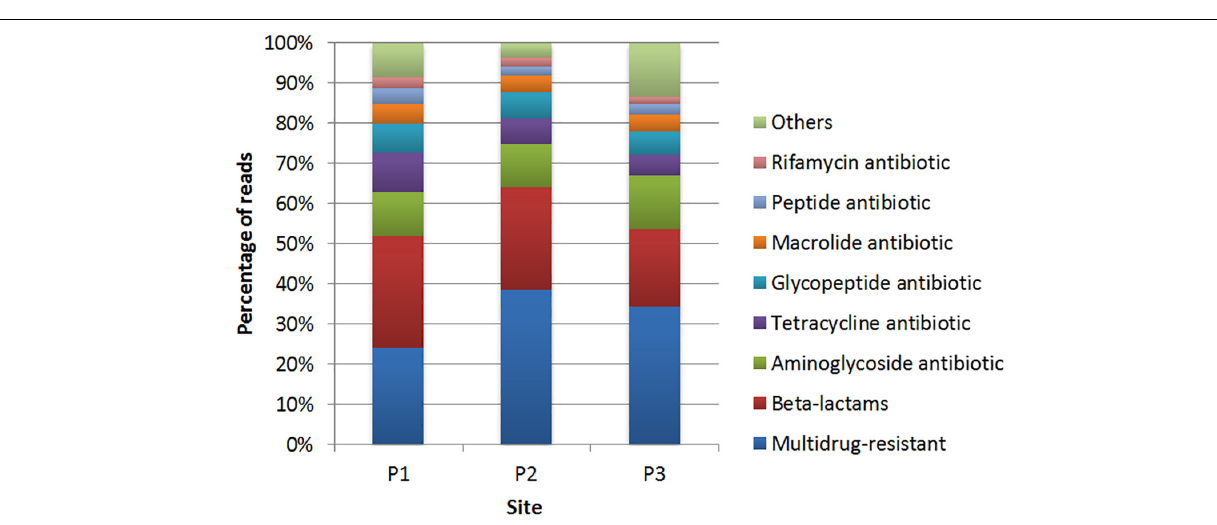
medium with imipenem, with 16 and 13 isolates, respectively.